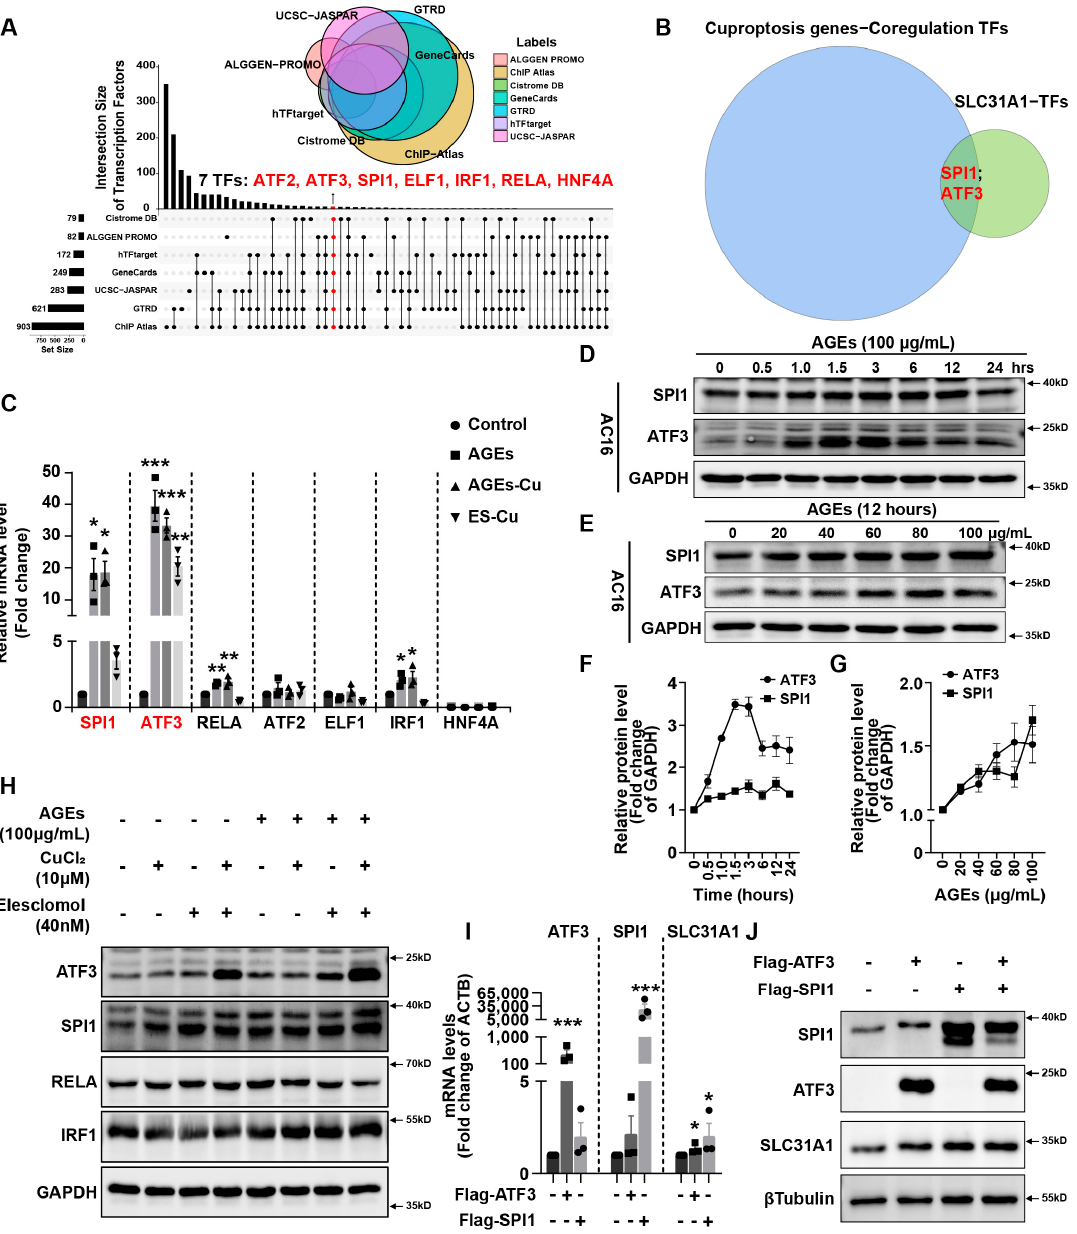
Figure 3. AGEs regulate SLC31A1 expression via ATF3/SPI1 in AC16 cardiomyocytes. ( A ) Upset-plot of Venn diagram of potential transcription factors of SLC31A1 predicted by varied databases. ( B ) Venn diagram of potential transcription factors between cuproptosis gene and SLC31A1. ( C ) mRNA levels of potential transcription factors in AC16 cells treated with AGEs, AGEs–Cu or ES–Cu for 24 h. ( D ) Western blot analysis of SPI1 and ATF3 of AC16 cells treated with AGEs with indicated time-points. ( E ) Western blot analysis of SPI1 and ATF3 of AC16 cells treated with AGEs with gradient concentrations. ( F , G ) The line charts of the quantifications of corresponding western blotting image in D and E. ( H ) Western blot analysis of SPI1 and ATF3 of AC16 cells treated with indicated ES–Cu with and without AGEs. ( I ) mRNA levels of SLC31A1 in AC16 cells overexpressed SPI1 or ATF3. ( J ) Western blot analysis of SLC31A1 in AC16 cells overexpressed SPI1 and/or ATF3. ES, elesclomol. * p < 0.05, ** p < 0.01, *** p <